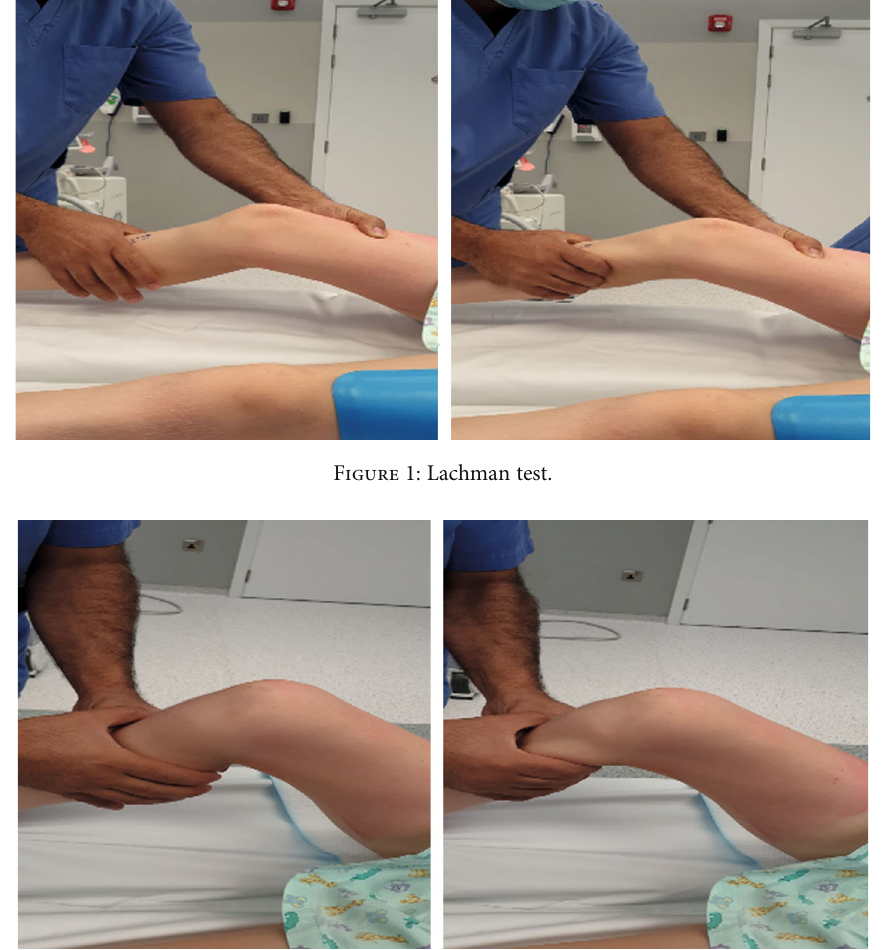
Figure 2: Anterior drawer test.